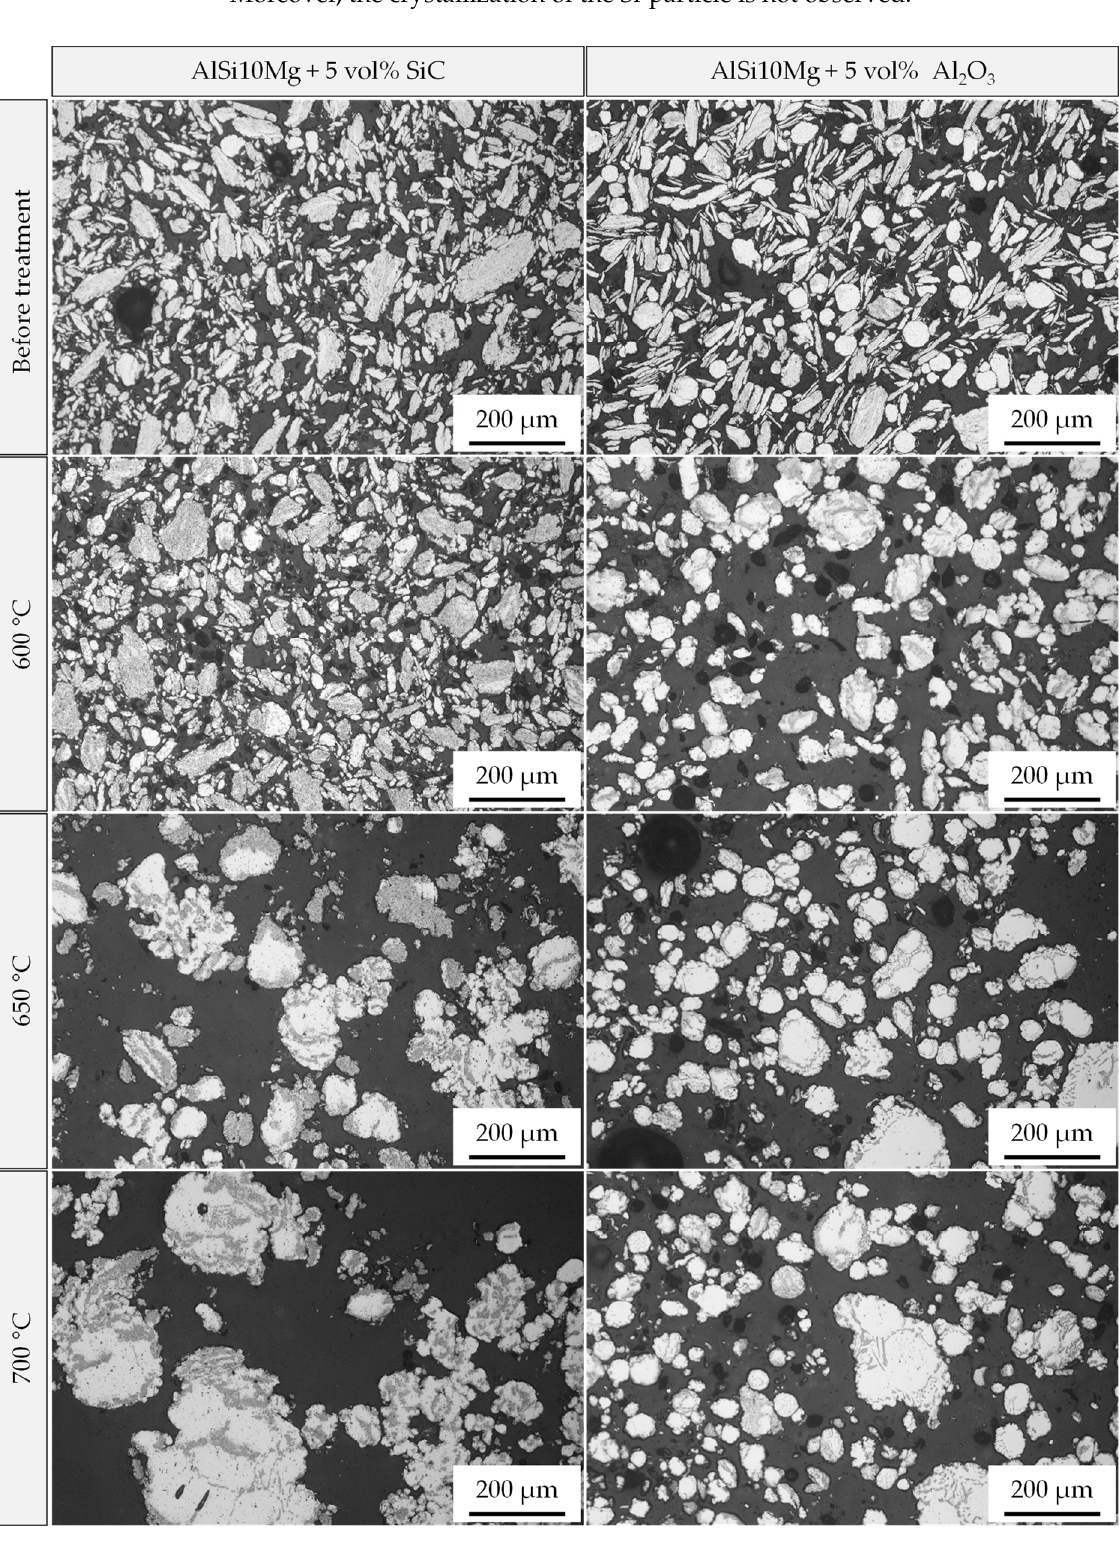
Figure 11. Light microscopic images of the composite powders after a thermal post-treatment in a tube furnace at different temperatures for 1 min above the melting point of the AlSi10Mg alloy for 5 vol% SiC and Al 2 O 3 reinforcement (composite powders produced with menthol as PCA).